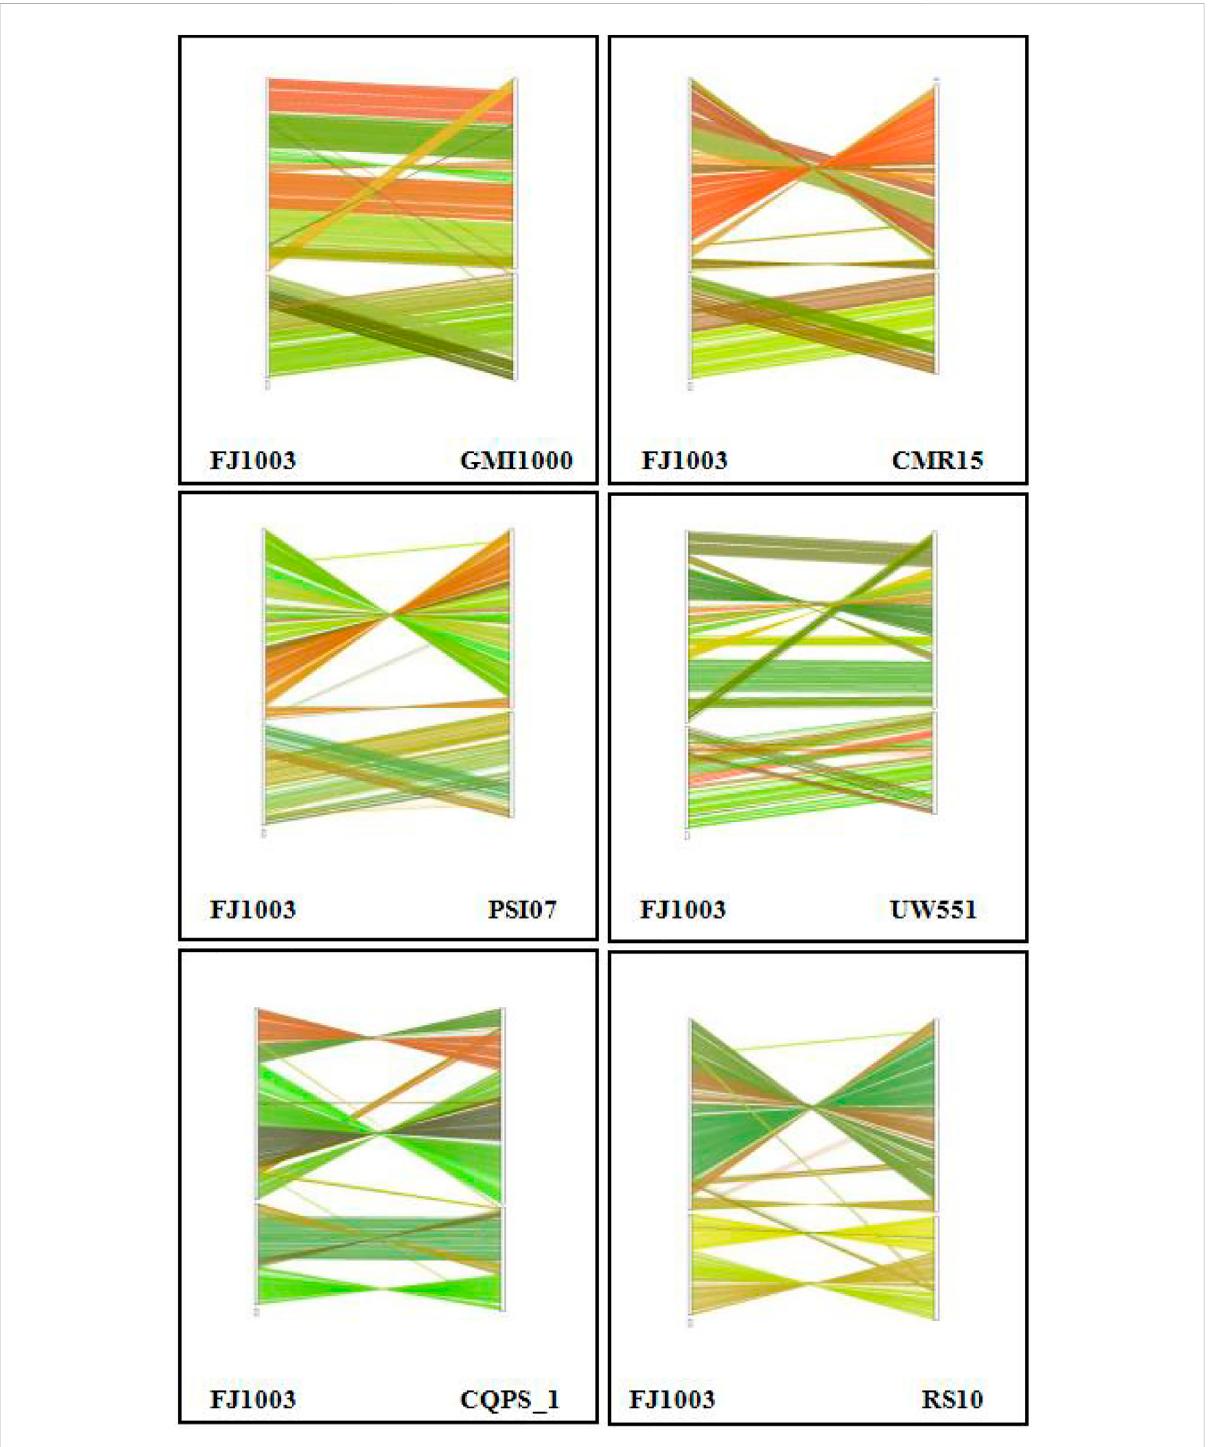
FIGURE 6 The collinear relationshipbetweenthe FJ1003 strain and other strains. The genome location coordinates of thereferencenear-sourcespecies are measured on the left, while the assembled genome location coordinates are on the right. The lines in the fi gure represent the collinear regions between the two species. Lines of different colors represent different collinear areas between different chromosomes. The color of the lines is automatically assigned by the